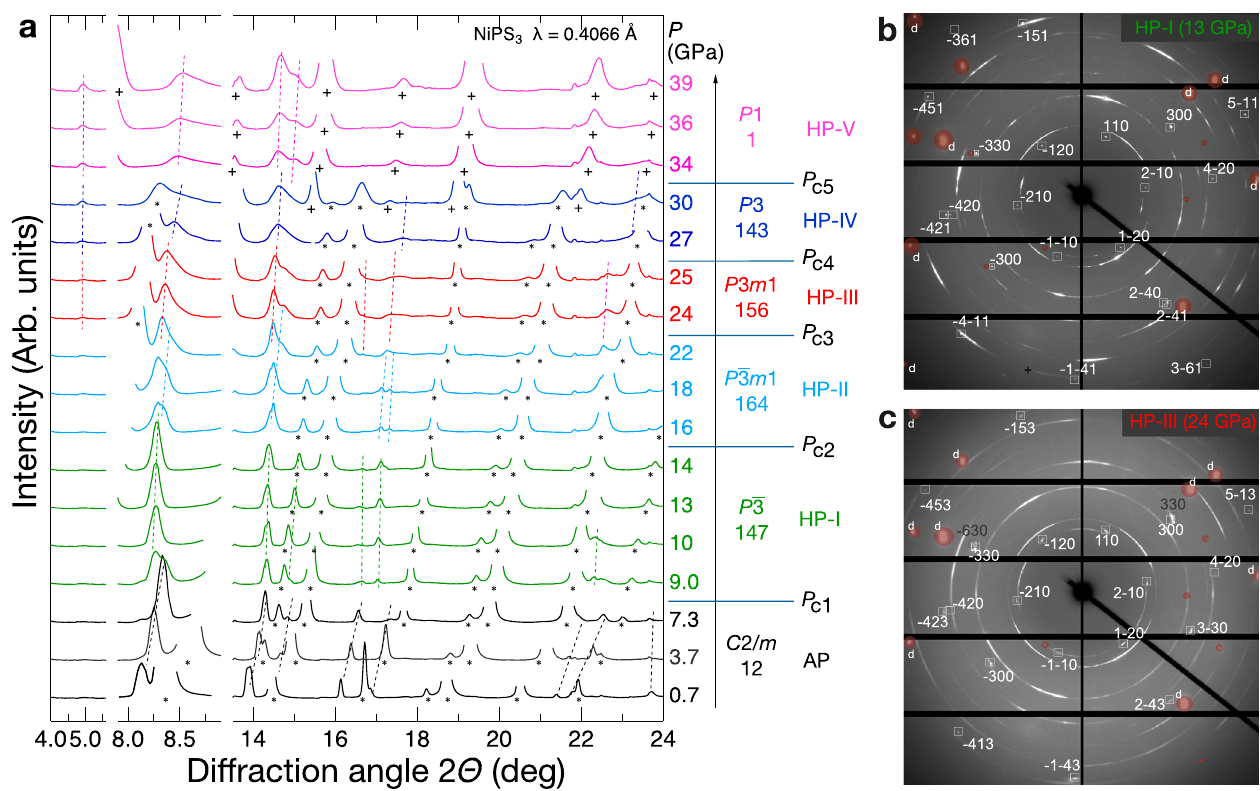
Fig. 3 High-pressure X-ray scattering results of NiPS 3 up to 39 GPa. a Integrated X-ray diffraction pro fi les under pressure. The appearance of X-ray diffraction peaks at the given angle are indicated, alongside dashed lines to guide the eye. Critical pressures, dividing individual pressure phases, are indicated by solid blue horizontal lines. The space groups of individual high-pressure phases are labeled. The asterisk (*) and plus ( + ) marks correspond to the diffraction response from NaCl in B1-type structure (below 30 GPa) and B2-type (above 30 GPa) 46 . b , c The X-ray diffraction images on the detector for HP-I (13 GPa) and HP-III (24 GPa). The peaks from NiPS 3 are enclosed with squares alongside the hkl indices for each phase. The gray labels in c indicate the diffraction from HP-II. The Bragg diffraction from the diamond anvils is masked with red